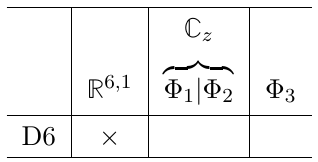
Table 1 . IIA setup dual to M-th. on R 6 , 1 ×